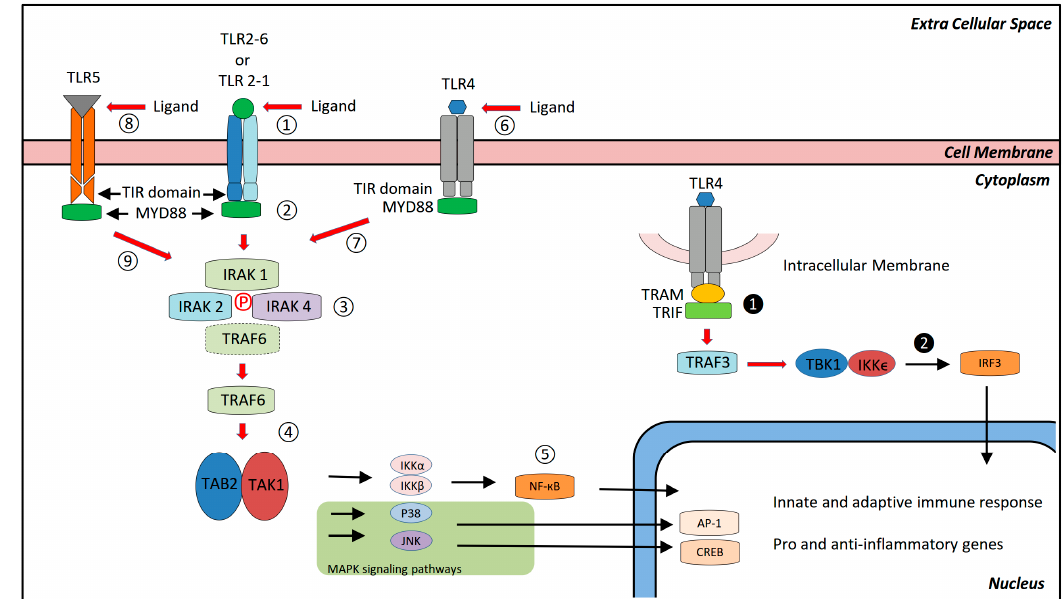
Figure 2. Schematic and simplified representation of the TLR2, TLR4, and TLR5 signaling pathways. Upon ligand recognition, TLR2 is activated and dimerizes with TLR1 or TLR6 ① . A MYD88-dependent intracellular pathway is therefore initiated with ligation of MYD88 (myeloid differentiation primary response protein 88) to the cytoplasmic TLR domain TIR (Toll-IL-1 receptor) ② . MYD88 recruits the IRAK (IL-1R-activating kinases) complex and TRAF6 (TNF-receptor associated factor 6). Phosphorylation of the IRAKs induce activation and release of TRAF6 from the complex ③ . TRAF6 then activates the TAK1-binding protein 2 and TGF-activated kinase 1 (TAB2-TAK1) complex ④ . Finally, the I к B kinases- α and β (IKK α and IKK β ) complex, responsible for activation of the transcription factor (NF- κ B) that translocates into the nucleus, where it regulates gene expression of mainly pro-inflammatory genes ⑤ . Moreover, TRAF6 activates the mitogen-activated protein kinases (MAPKs) signaling pathway (JNK and P38), whose final effect is the activation of transcription factors AP-1 and CREB. TLR4 homodimers, following TLR4-ligand interaction ⑥ . Induce activation of a MYD88-dependent pathway ⑦ , as well as MYD88-independent pathway ❶ . The second pathway starts with recruitment of TRAM (TRIF-related adapter molecule) to the TIR domain of the TLR4 homodimers and follows with recruitment of TRIF (TIR domain-containing adaptor inducing IFN- β ) ❶ . TRIF activates TRAF3 and, finally, the transcription factor IRF3 (Interferon Regulatory Factor 3) via recruitment of TANK-binding kinase 1 (TBK1) and IKK ϵ ❷ . IRF3 translocates to the nucleus, where it induces the expression of type I interferon (INF) genes. TLR5 ligand (flagellin) activates TLR5 ⑧ and, because of this, the MYD88-dependent pathway described above and in the text ⑨ . The final effect is the expression of pro-inflammatory genes.